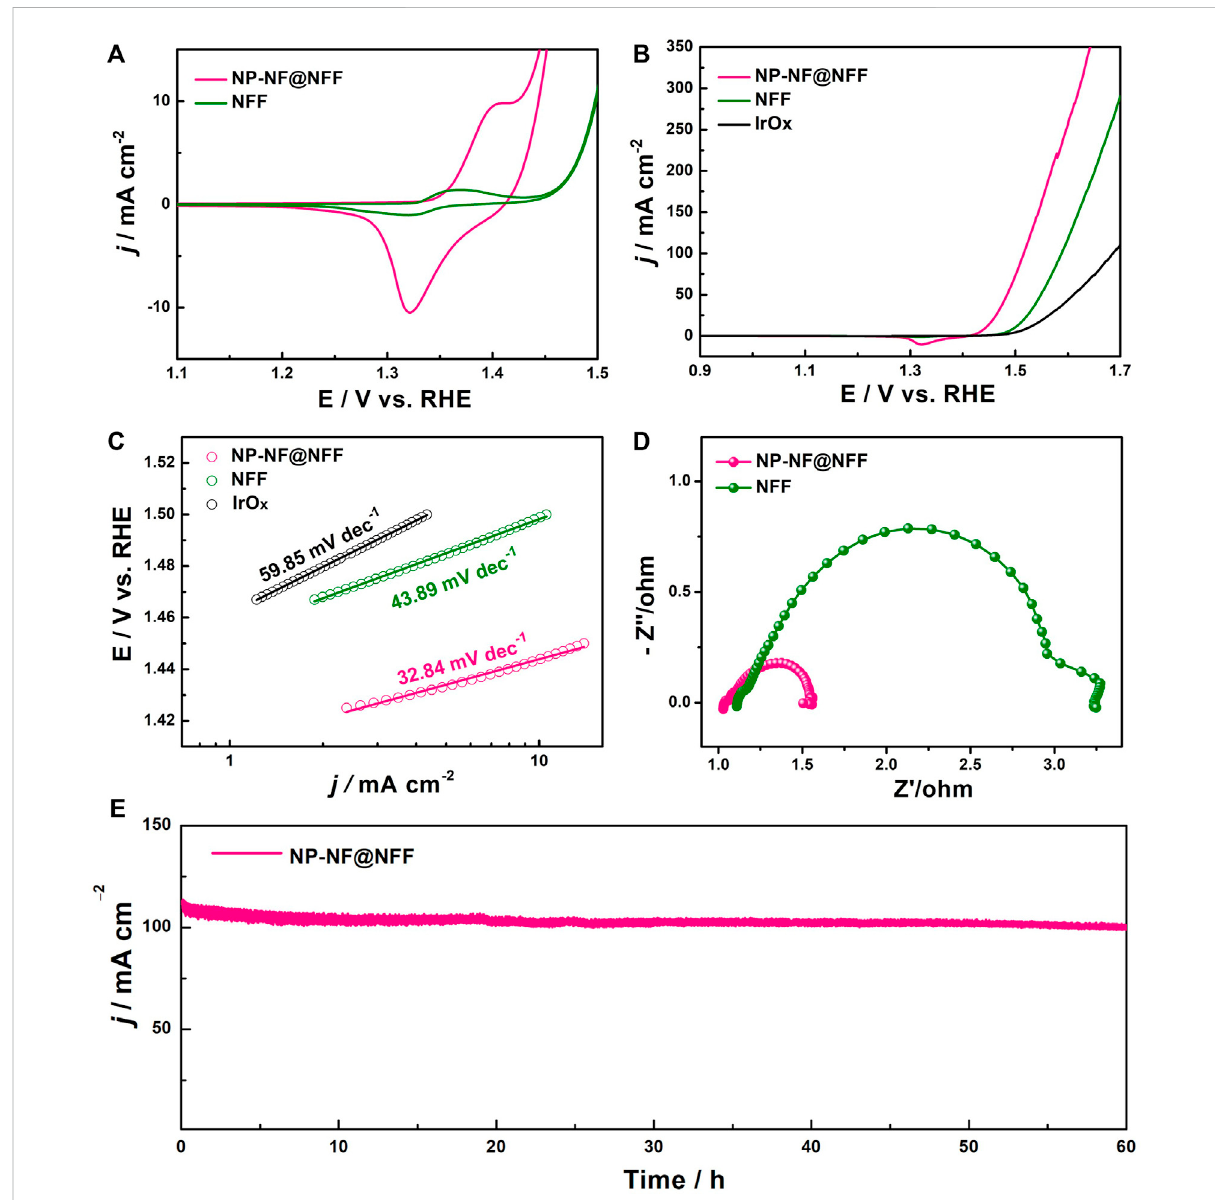
FIGURE 4 (A) Cyclic voltammetry curves, (B) linear sweep voltammetry curves and (C) corresponding Tafel slopes of NP-NF@NFF, NFF and IrOx; (D) Nyquist plots of NP-NF@NFF and NFF; and (E) chronopotentiometry curve at 1.53 V vs. RHE for